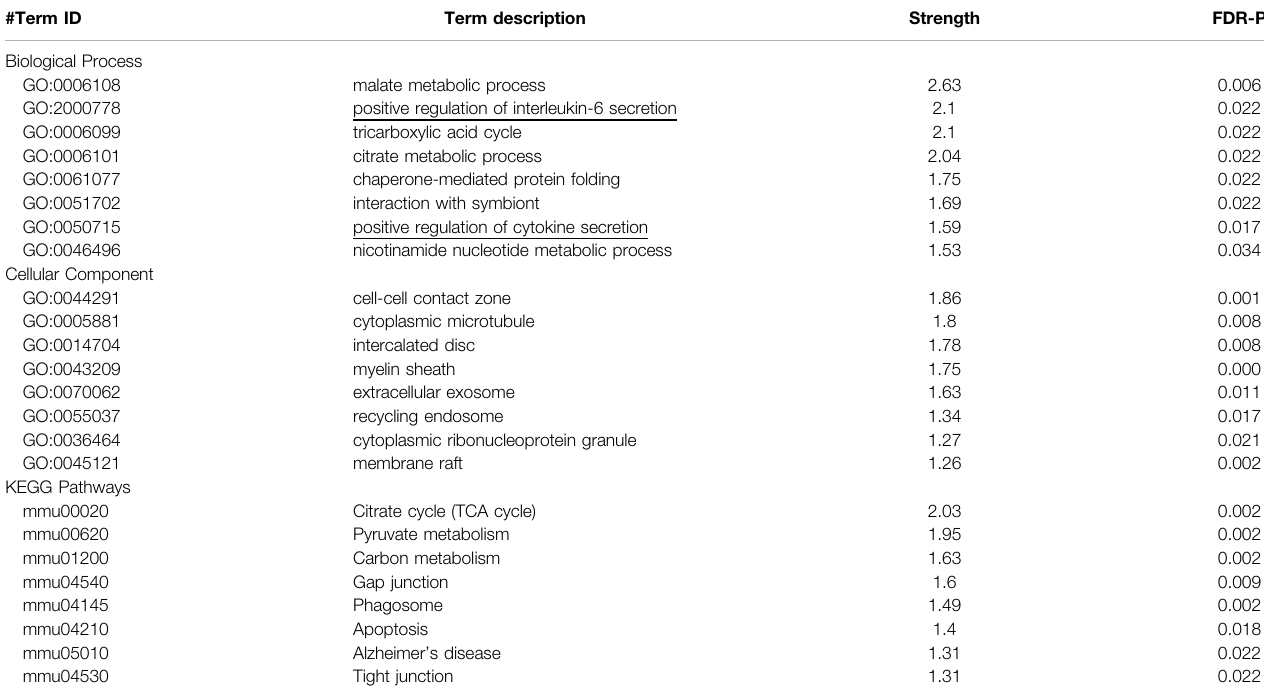
TABLE 1 | Pathway analyses of proteins that differed in expression in the VHIPP of Pde11a KO vs WT mice.